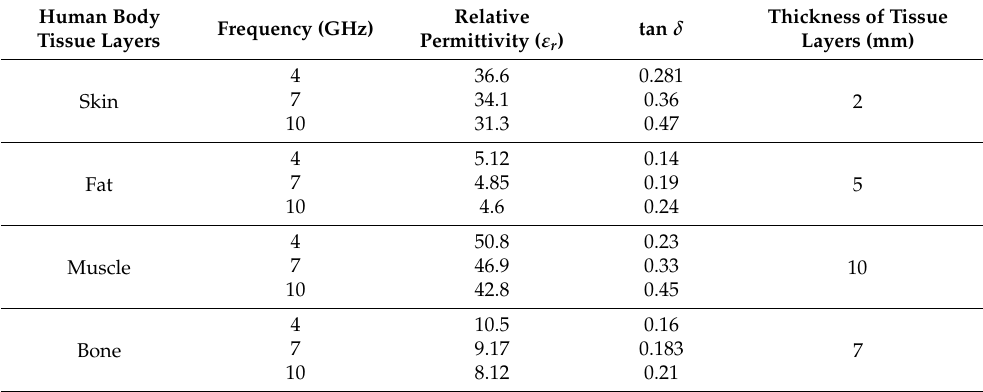
Table 2. Electrical properties of human body tissues.